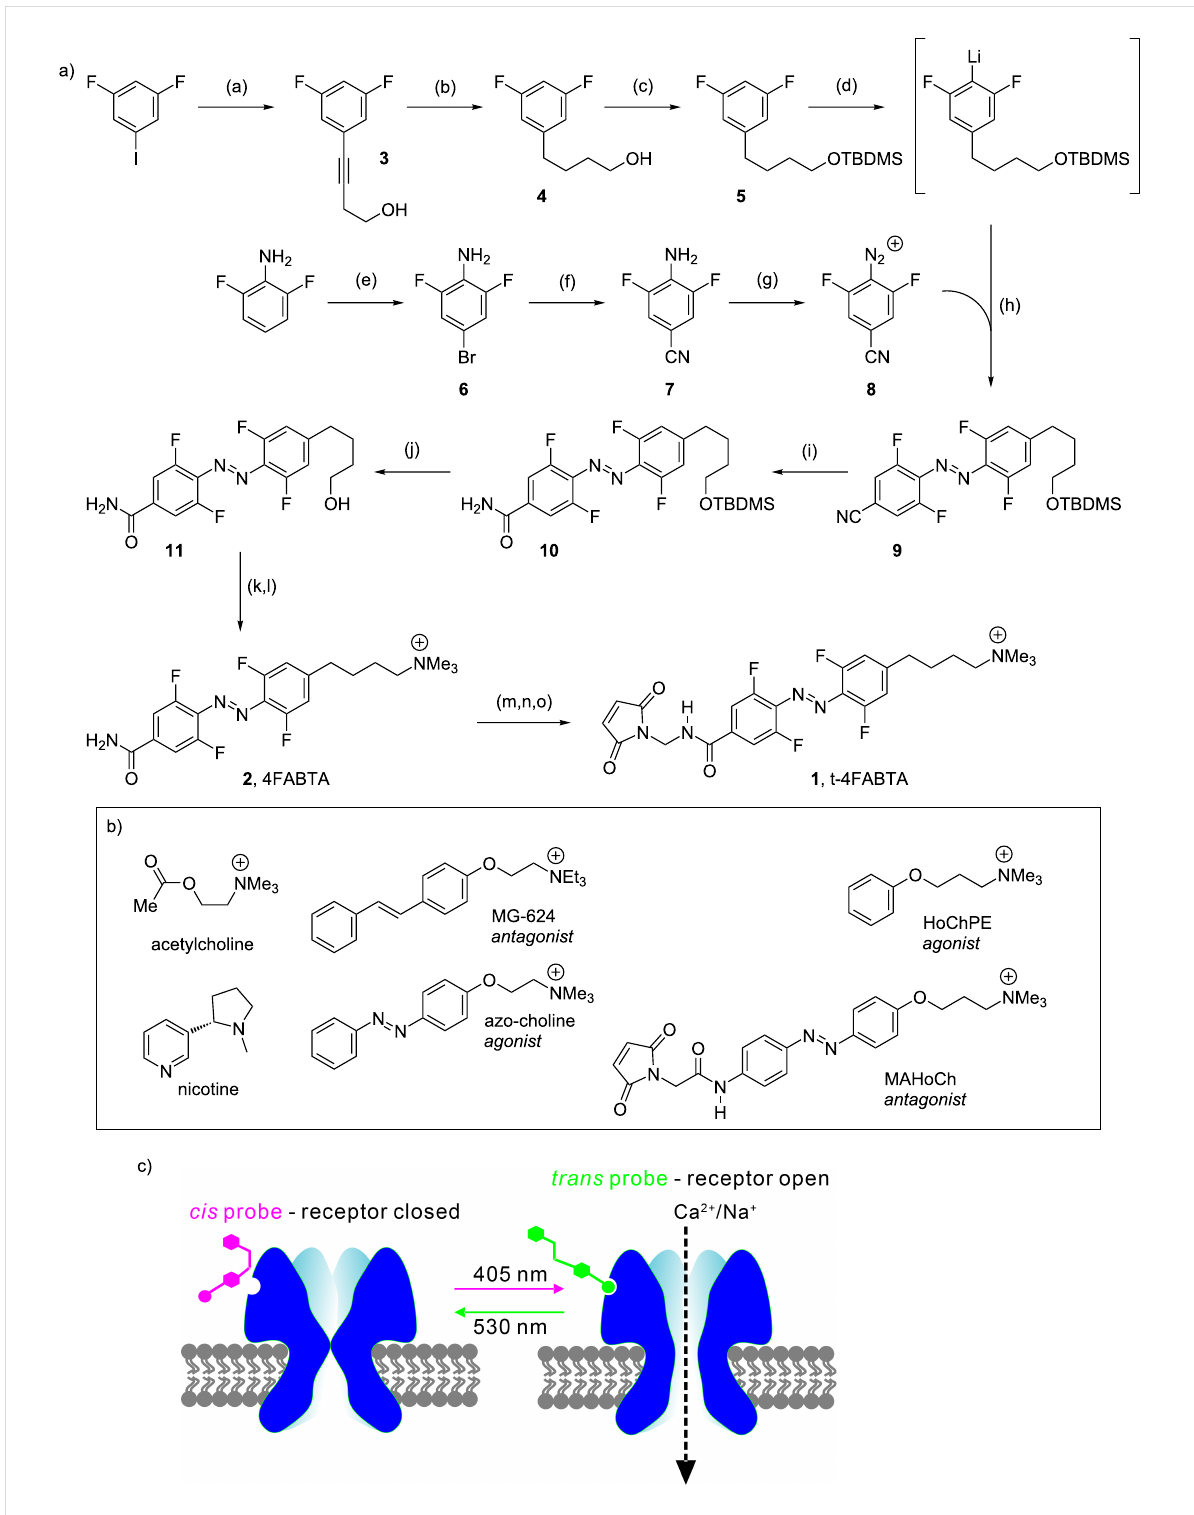
Scheme 1: Synthesis of 4FABTA. a) Reagents and conditions: (a) 3-Butynol, PdCl 2 (PPh 3 ) 2 , CuI, THF, rt, 93%; (b) H 2 , PtO 2 , EtOH, rt, 71%; (c) TBDMS-Cl, imidazole, DCM, rt, 96%; (d) n -BuLi, THF, − 78 °C to − 50 °C; (e) NBS, ACN, rt, 89%; (f) CuCN, NMP, 202 °C, 70%; (g) NOBF 4 , EtOAC, − 10 °C, 54%; (h) THF, − 78 °C, 17%; (i) Et 2 NOH, Cu(OAc) 2 , MeOH, rt, 49%; (j) TBAF, THF, rt, 71%; (k) PPh 3 , CBr 4 , THF, rt, 64%; (l)